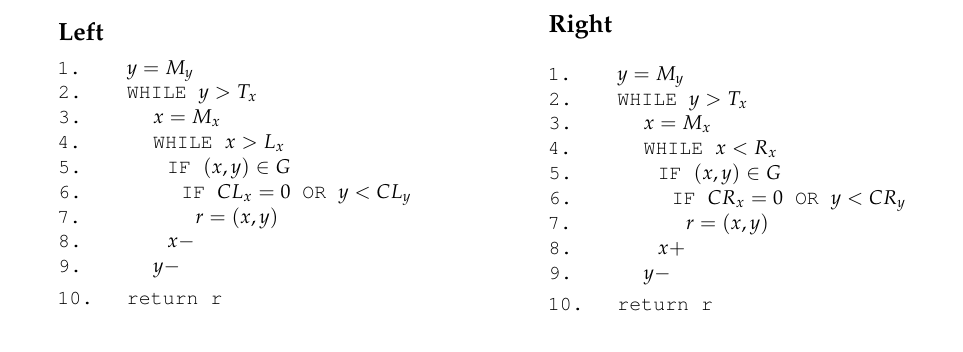
Algorithm 1: Pseudo-code for left and right neck line